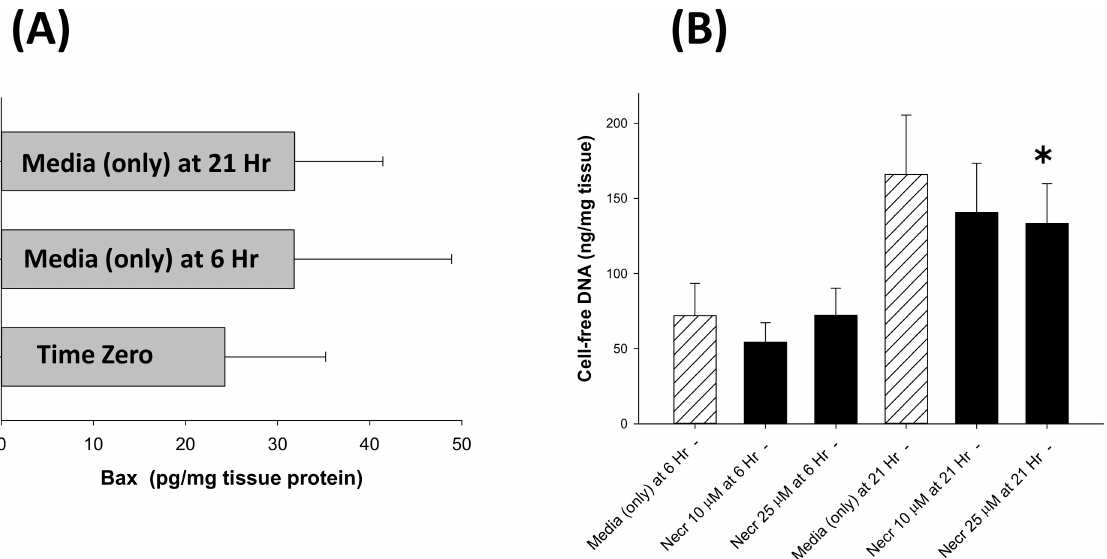
Fig 4. A) Bax expressionin placentalexplants: Horizontalbar graph demonstrating expressionof the pro-apoptotic Bax protein in homogenates of mouse placentalexplantsculturedin 21% O 2 conditions at time zero, 6 hours and 21 hours in the presenceof tissue culture media alone. Bax expressionnormalizedfor tissue protein and reportedas picograms (pg) per mg tissue protein; data reportedin mean ± S.D., N = 16–21, and althougha suggestive trend, the apparentincreasein Bax expressionwas not statistically significant.B) Cell-free DNA responseto necrostatin-1: Bar graph demonstrating cell-free DNA (cfDNA) release into the culture media by mouse placentalexplantsculturedin 21% O 2 conditions at 6 hours and 21 hours in the presenceof tissue culture media alone (hatchedbars) or necrostatin-1 (Necr; black bars); data reportedin mean ± S.D., N = 6–57, and * = p < 0.05 comparedto culture media alone at 21 hours.